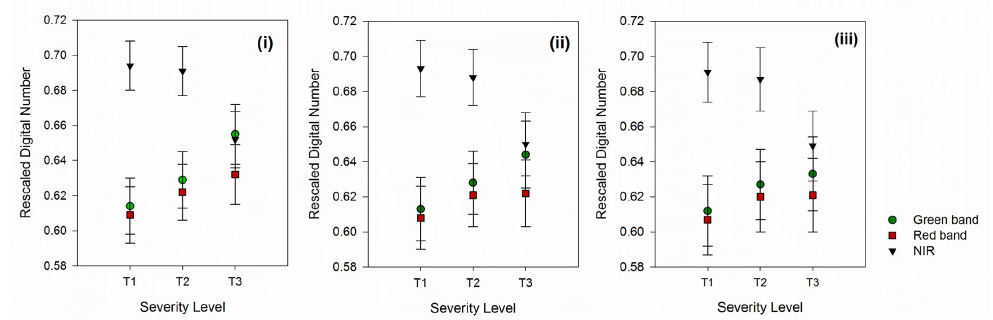
Figure 4. The mean and standard deviation of rescaled DN for ( i ) 1/7, ( ii ) 1/8, and ( iii ) 1/9 threshold limits in the three bands tested for the circle radius of 35 pixels.